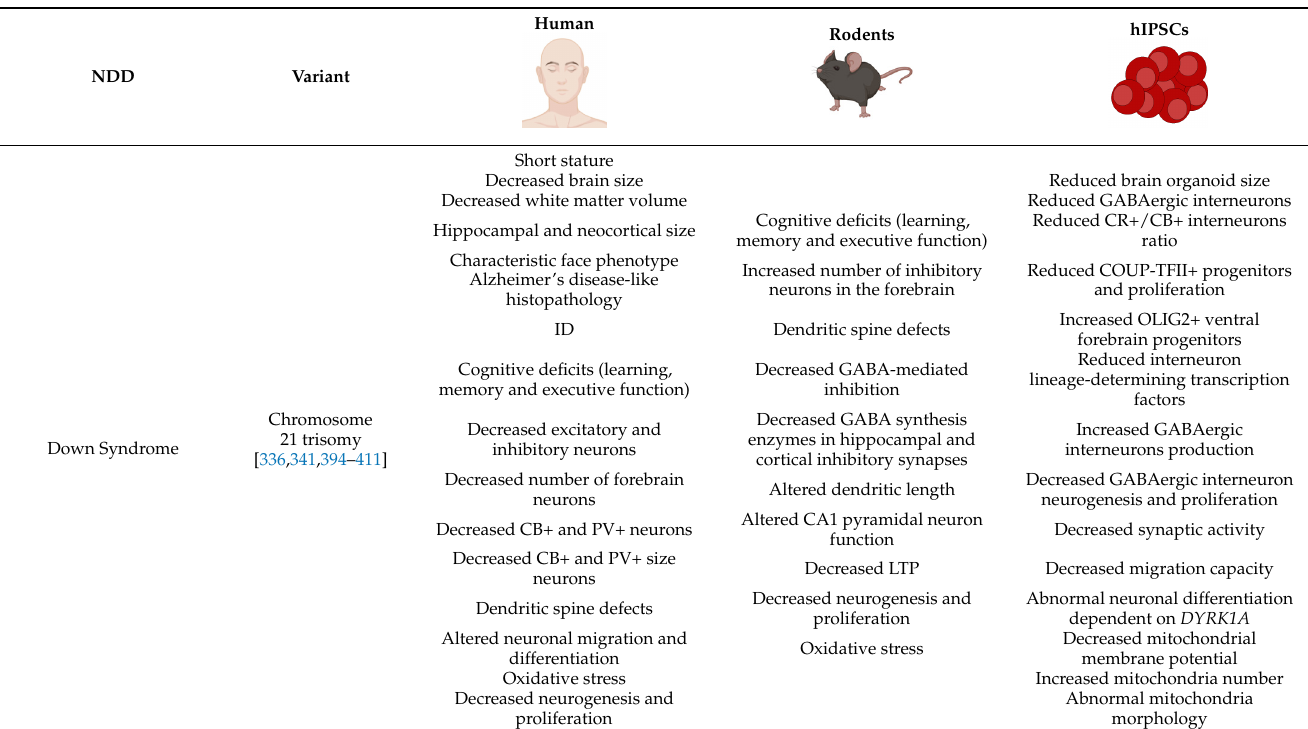
Table 3. Described ASD human, rodent and hIPSCs phenotypes.